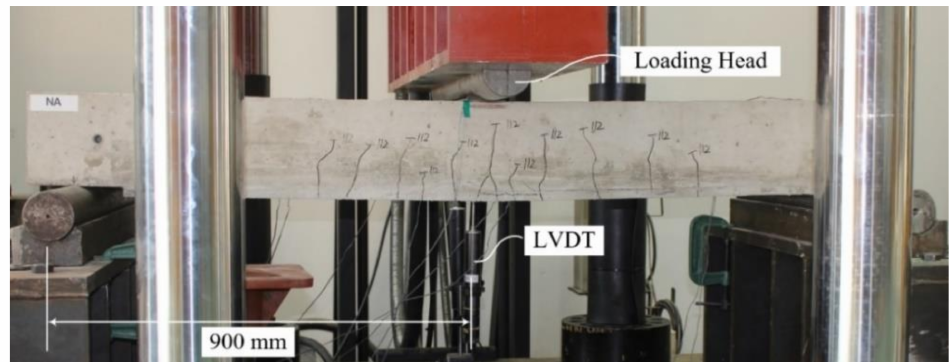
Figure 12. Flexural test setup and instrumentation.